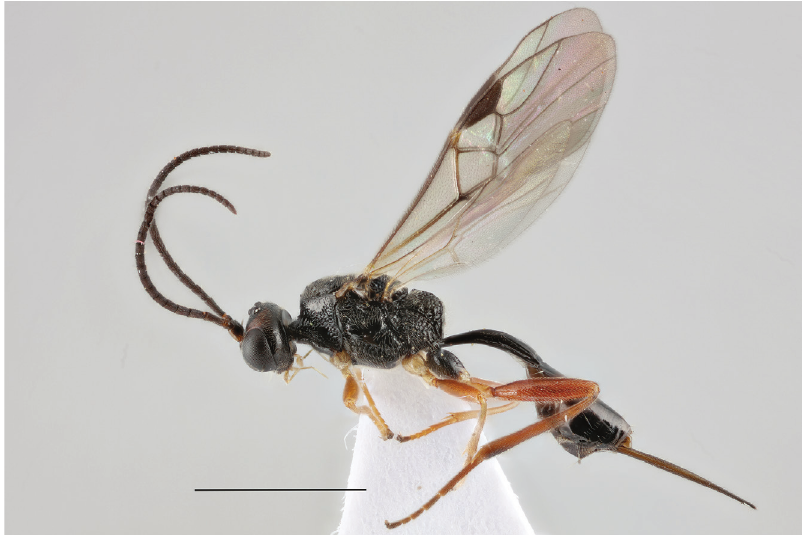
Figure 1. Lateral habitus of Orionis coxator (NHMUK014425411). Scale bar: 2